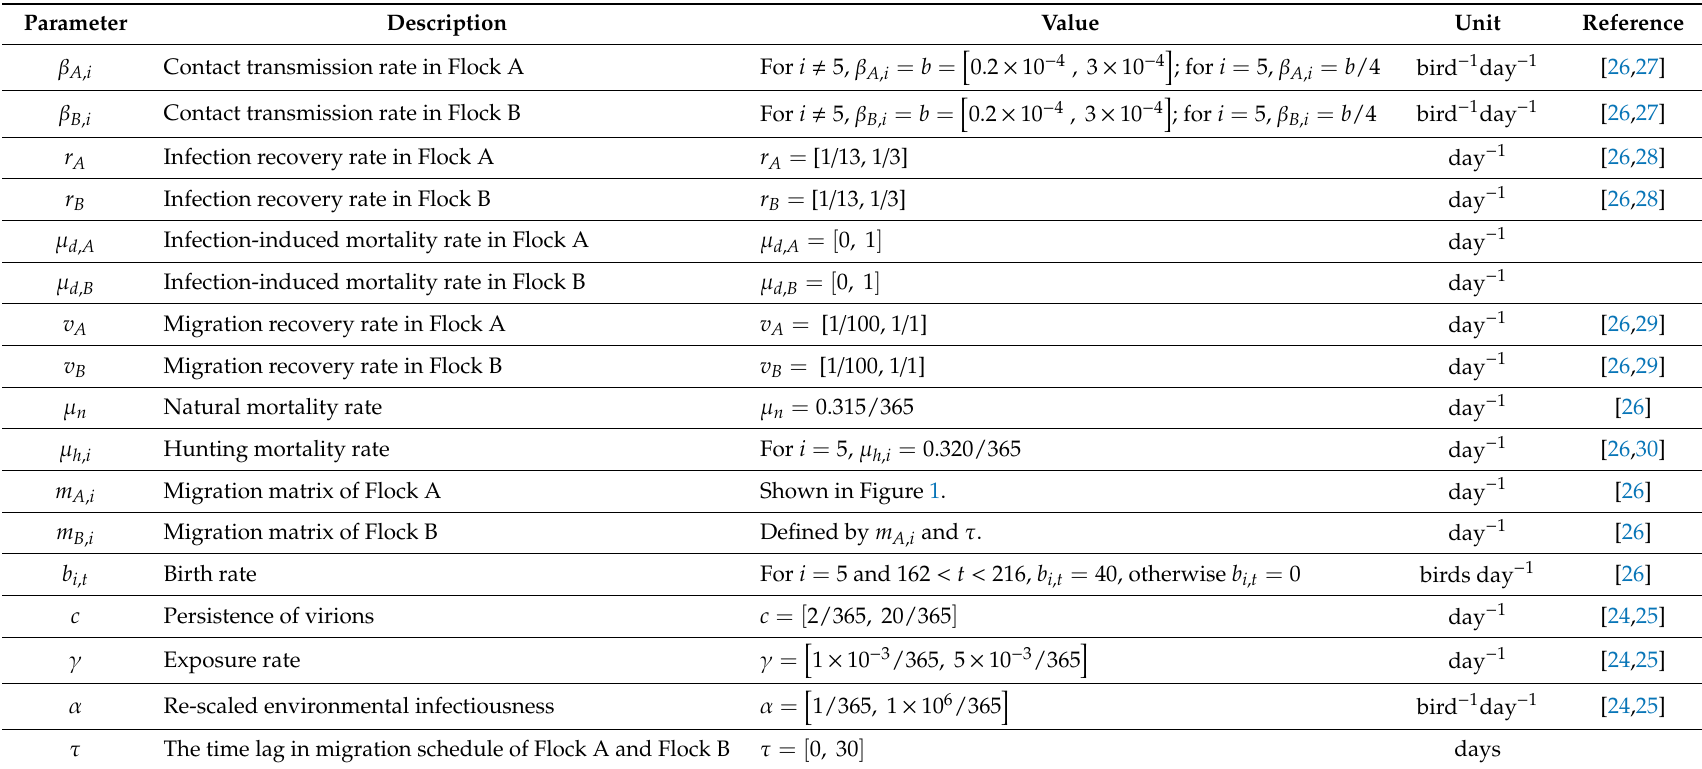
Table 1. Parameters in the